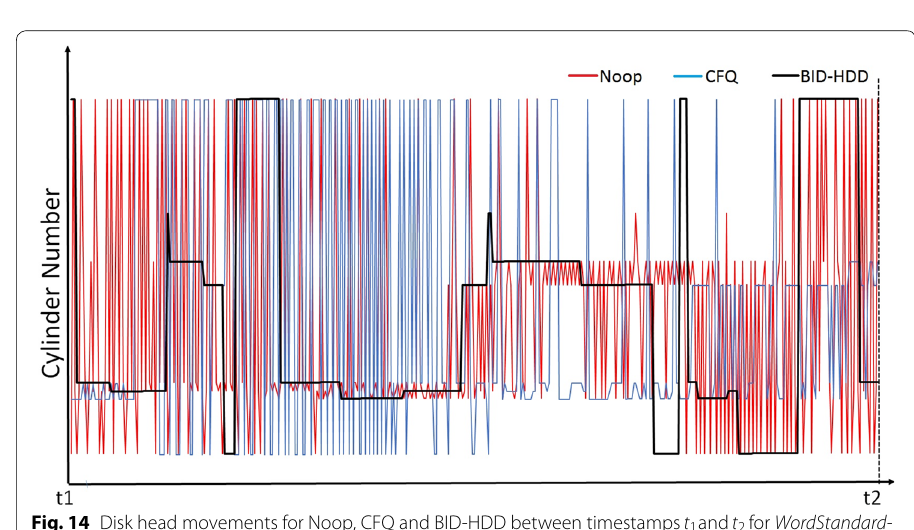
Fig. 14 Disk head movements for Noop, CFQ and BID-HDD between timestamps t 1 and t 2 for WordStandard-